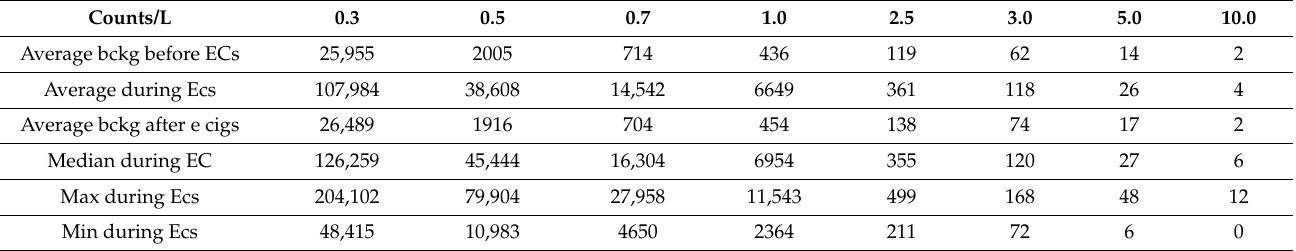
Pearson between bckg before EC use and during EC use = 0.953. Wilcoxon Signed-Rank test (bckg before and during EC use) p value = 0.012.